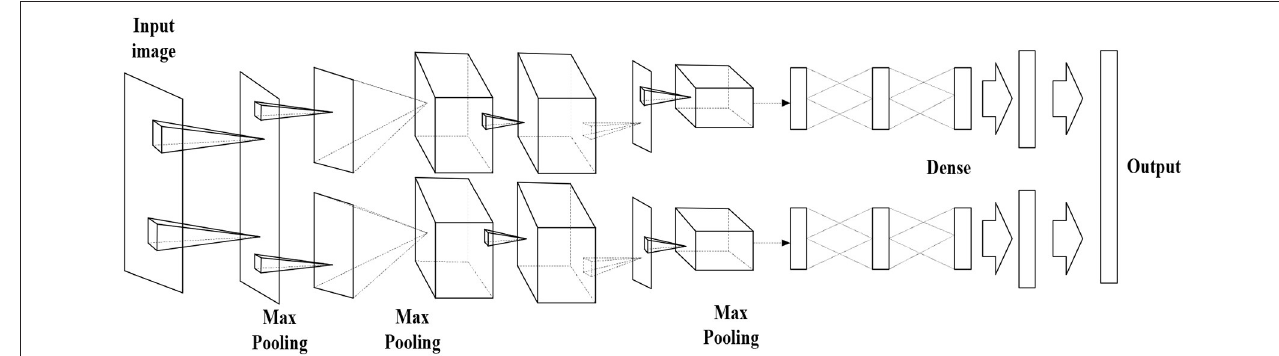
FIGURE 7 | Deep Convolutional Neural Network (DCNN)